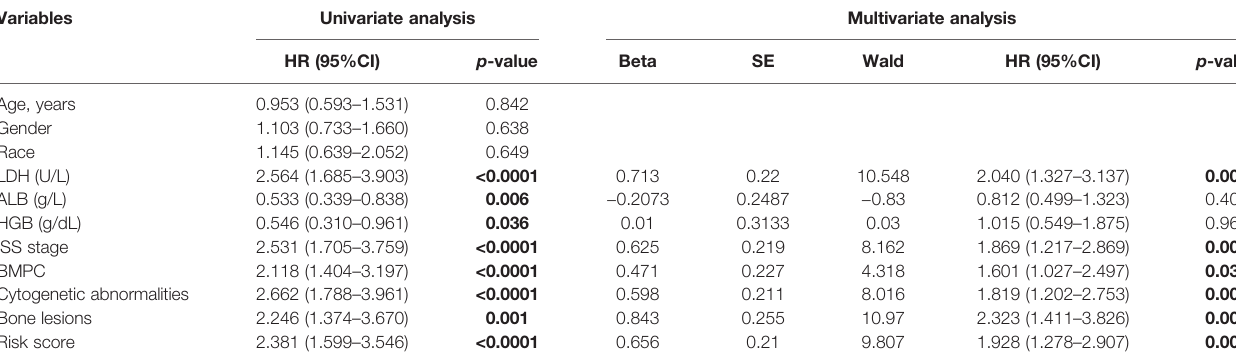
The bold values indicate statistically different (P<0.05).